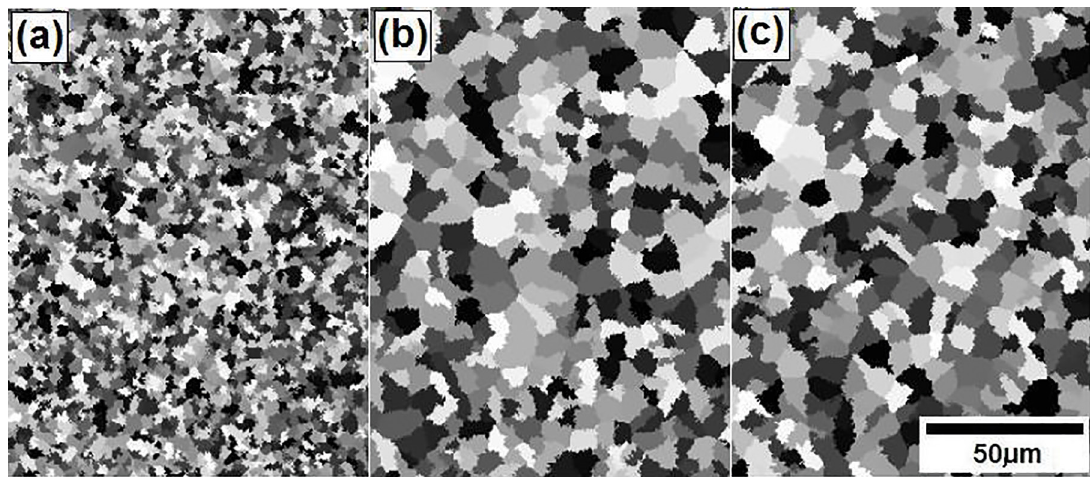
Figure 10: Microstructures generated by non-isothermal simulation at heating rates of 15 K/minute from the nucleation mechanisms of (a) site saturation, (b) temperature-independent rate, and (c) temperature-dependent